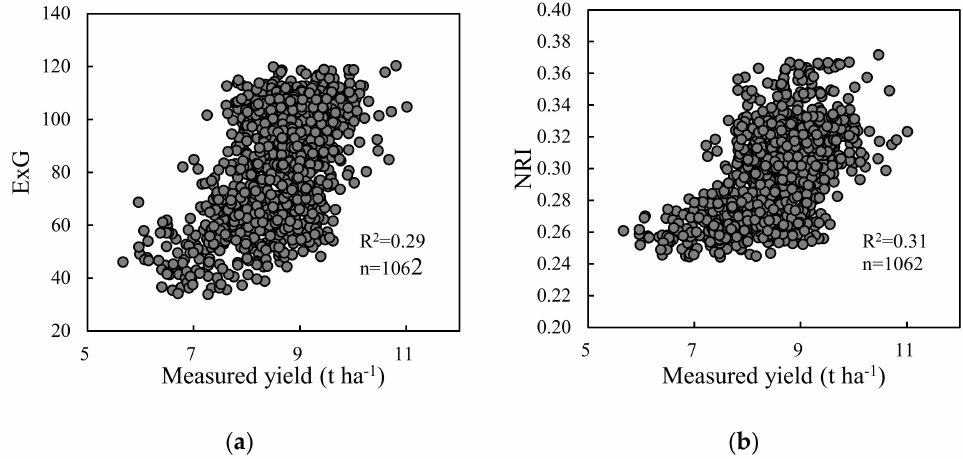
Figure A1. Vegetation indices vs. measured yield; ( a ) ExG and yield; ( b ) NRI and yield. These two vegetation indices were Figure